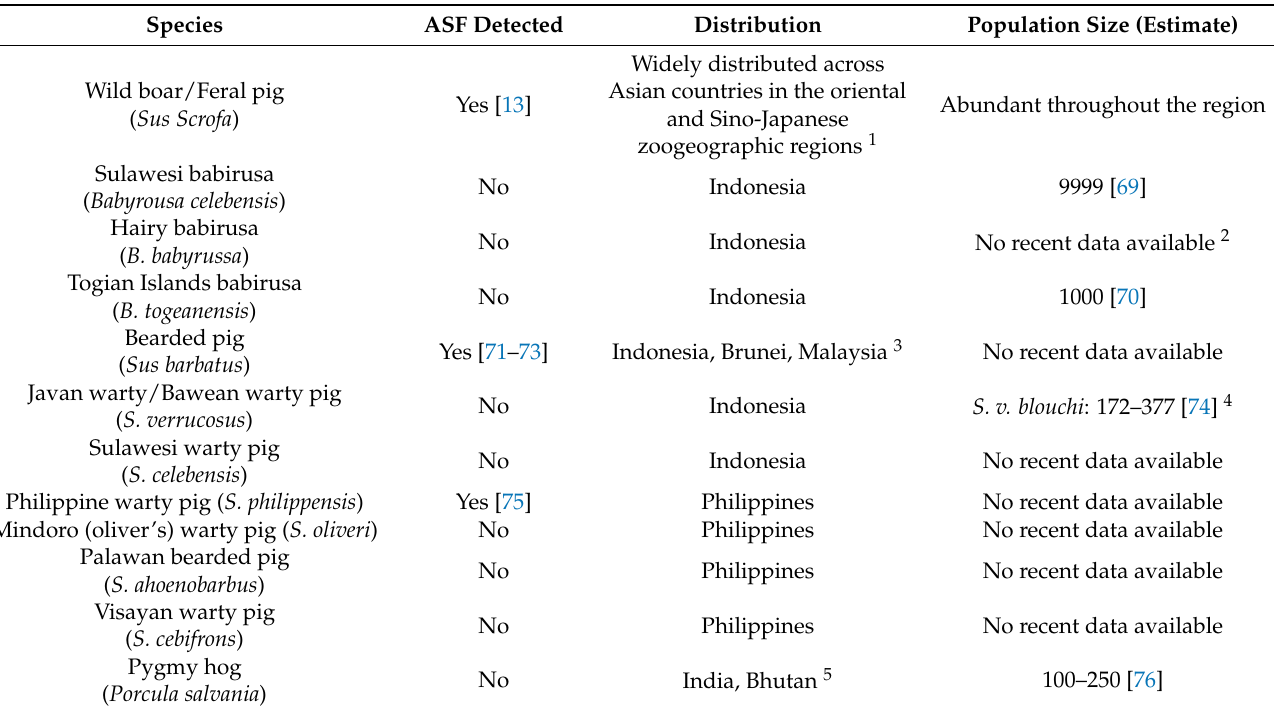
Table 2. Summary of wild suid species, current African swine fever (ASF) status, distribution, and population size (data mostly collected from the International Union for Conservation of Nature [15]) in the Asia Pacific region.